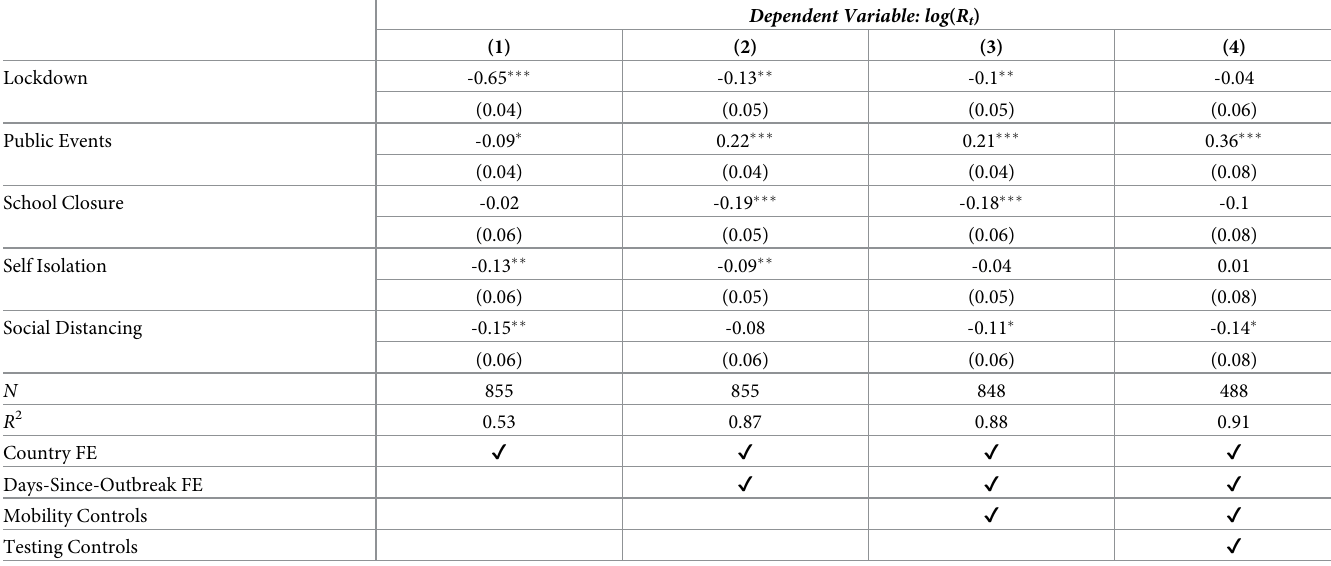
Table 2. Effective reproduction number after introduction of